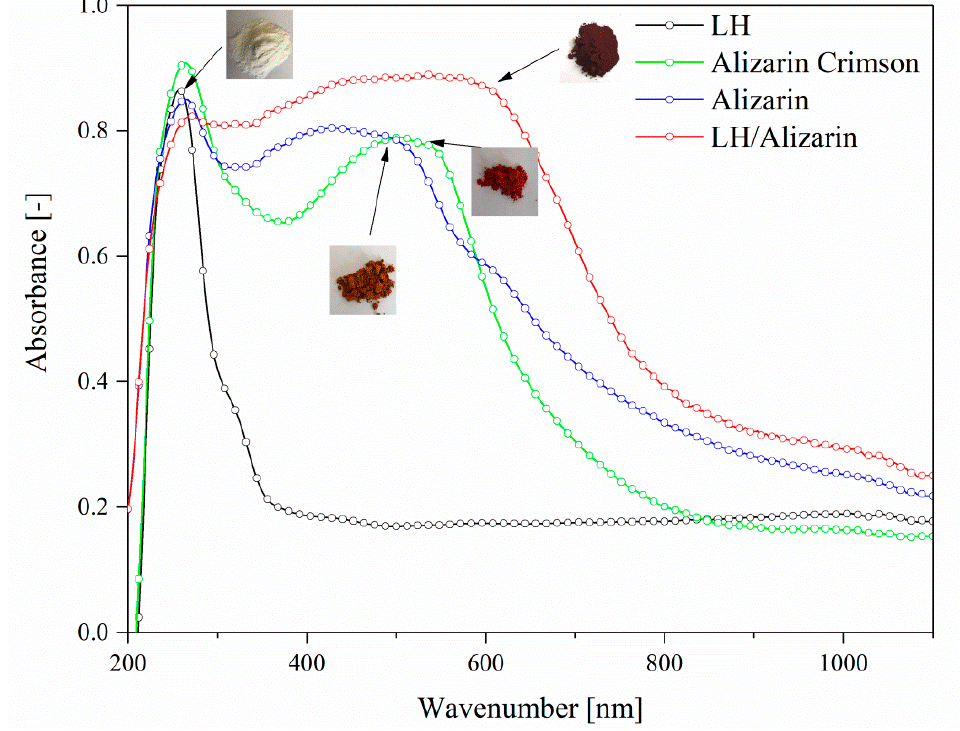
Figure 6. UV–Vis spectra of LH, alizarin, LH/Alizarin (10%), and Alizarin Crimson powders.